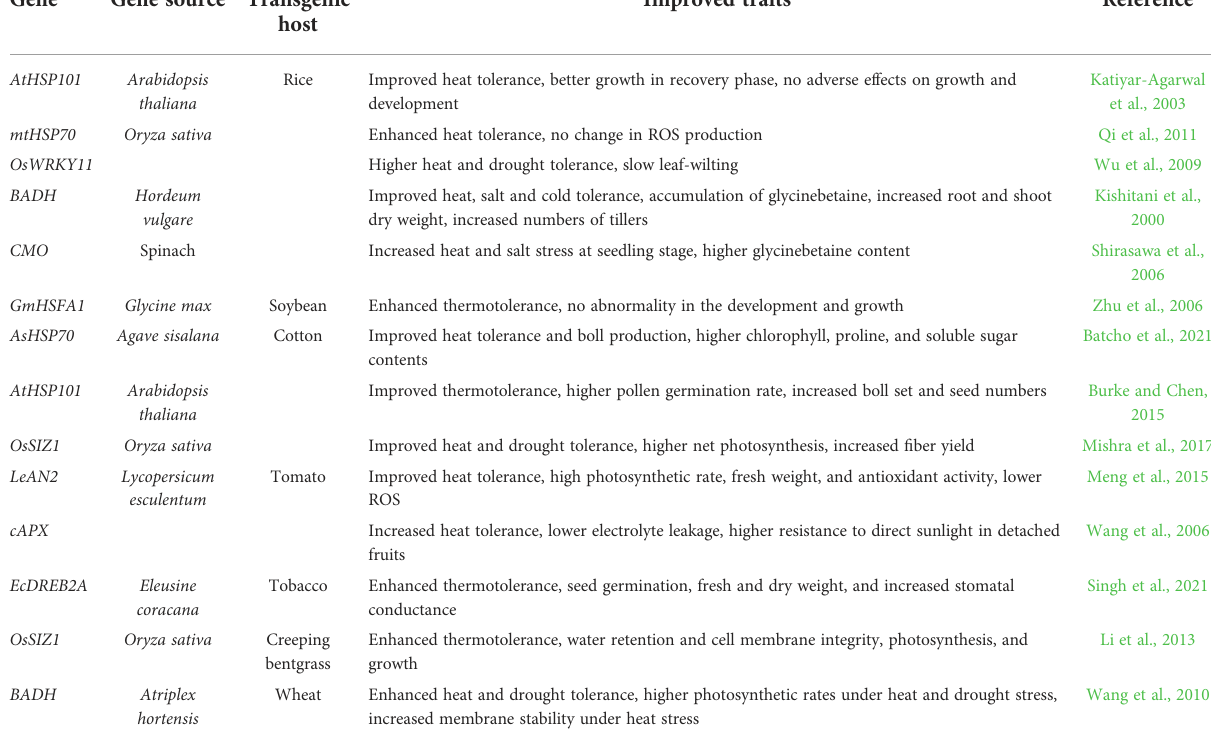
TABLE 3 Improving heat stress tolerance in transgenic